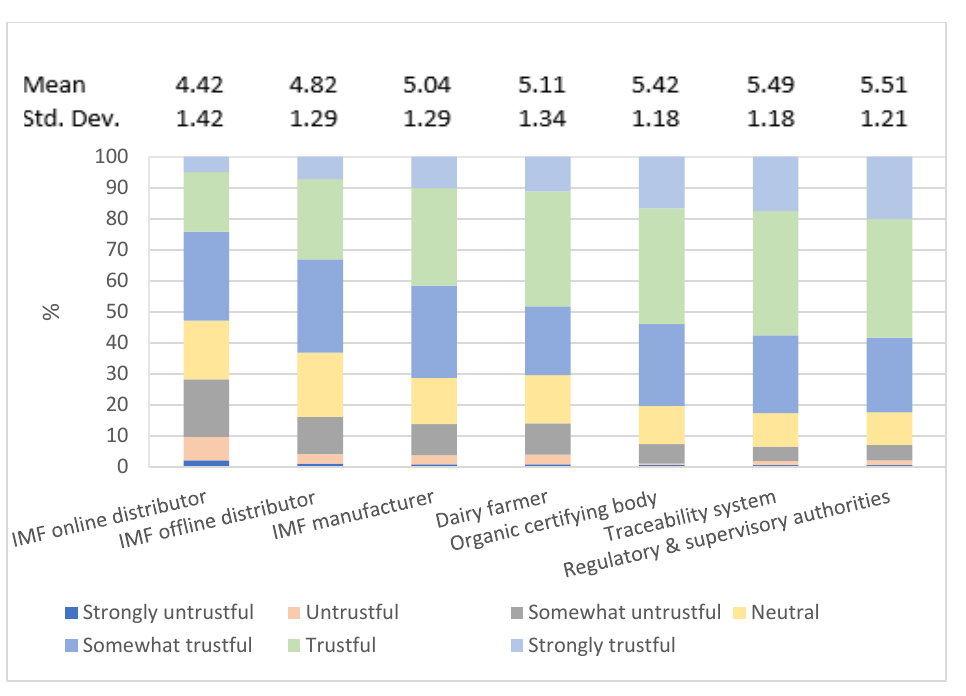
Figure 2. Respondents’ trust in IMF chain.